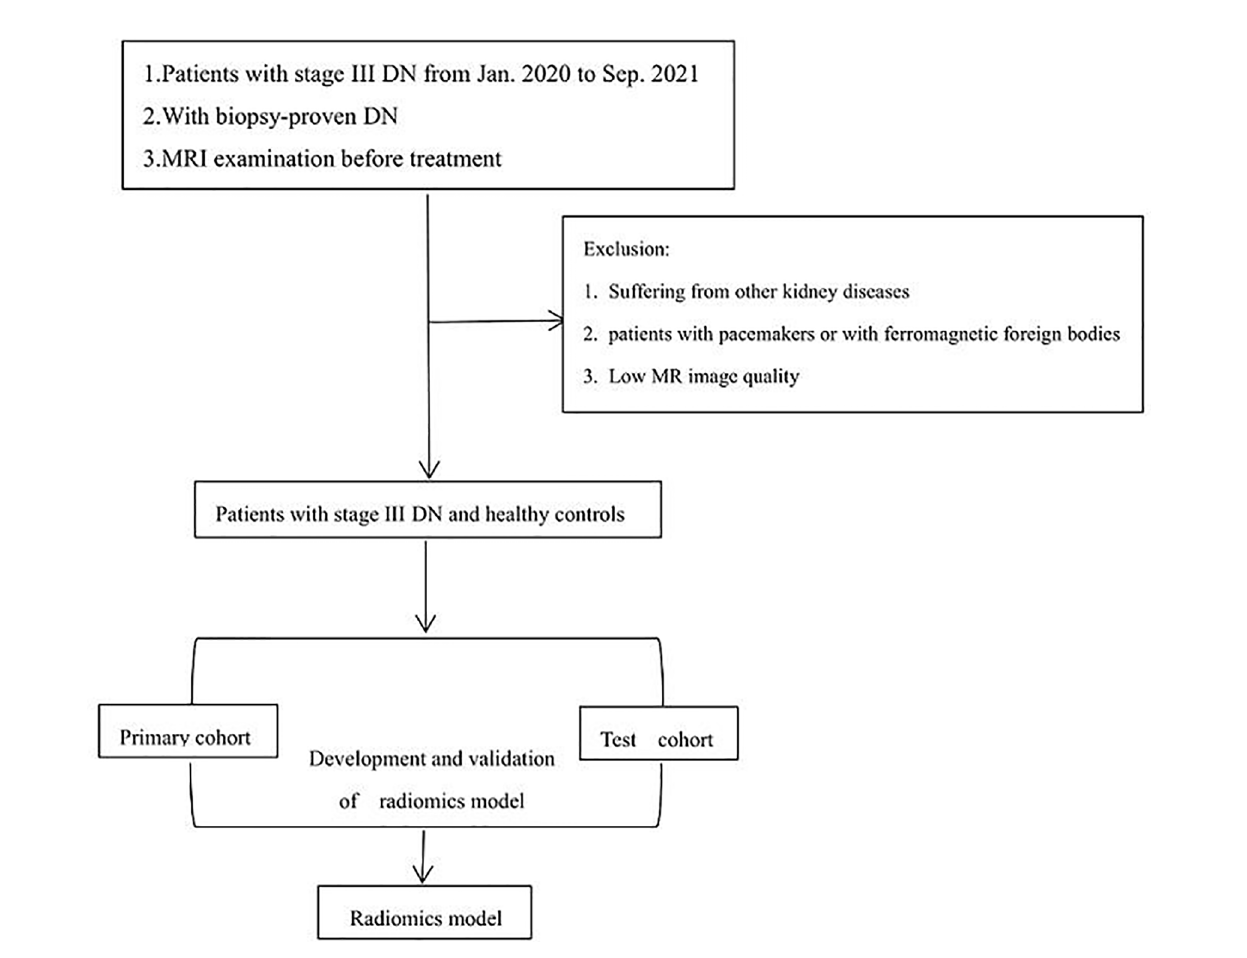
FIGURE 1 | Basic fl ow chart of this